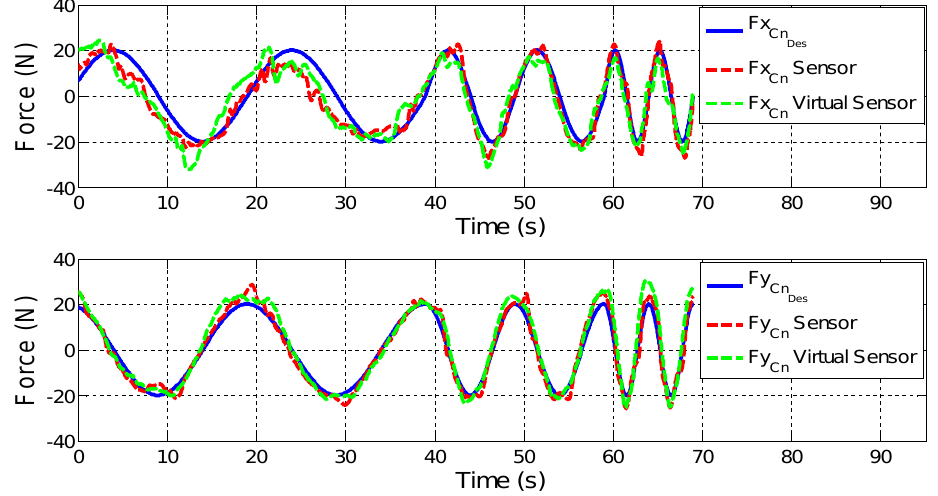
Figure 11. Validation of the Force Virtual Sensor in the ARM operating mode with variable force reference.